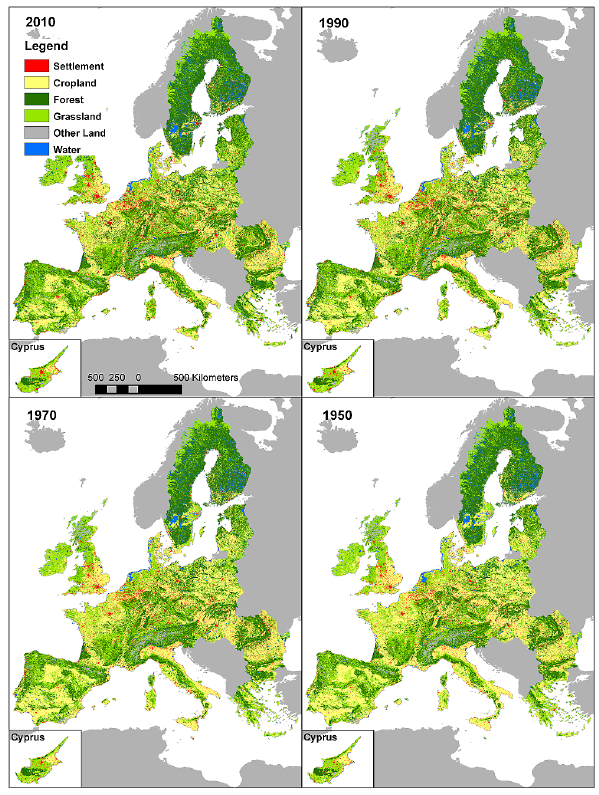
Fig. 4. Reconstruction results for four time steps: 2010, 1990, 1970 and 1950 and five classes (settlement, cropland, forest, grassland and other land; water mask is part of the other land class) for EU27+Switzerland.